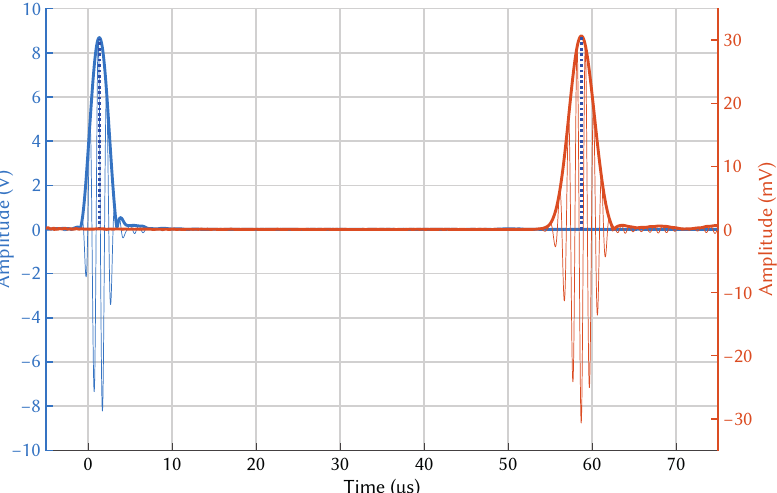
Figure 9. Experimentally measured wave propagation of the S 0 mode at room